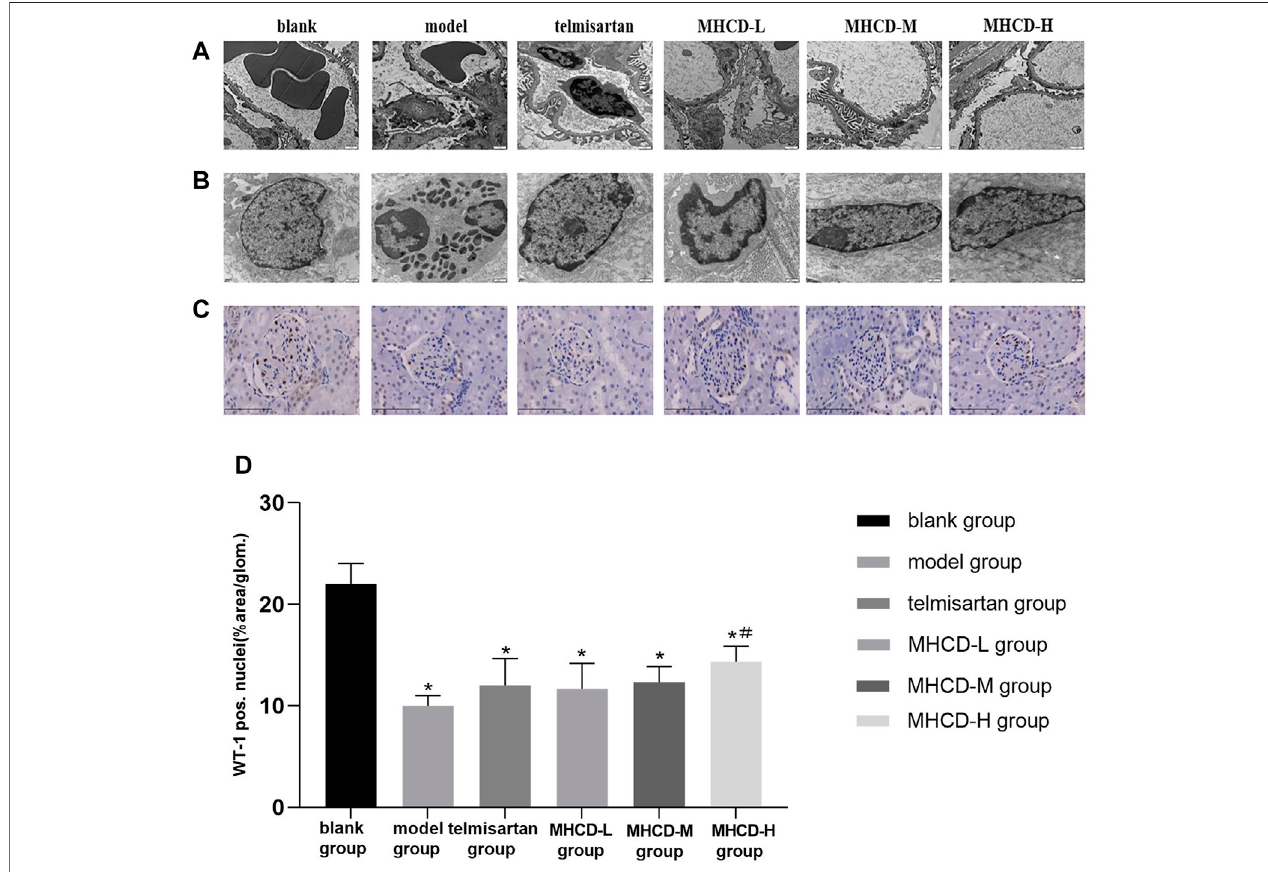
FIGURE 7 | MHCD protects against podocyte injury. (A) The foot process and basement membrane were observed under electron microscopy (magni fi cation × 8,200). (B) Changes in the fi ne structure of the foot process were observed under electron microscopy (magni fi cation × 16,500). (C) WT1 immunohistochemistry of the six groups (magni fi cation × 400). (D) Average percent staining area and WT1-positive podocytes per glomerulum in the IgAN rat model obtained using Image-Pro Plus 6.0 analysis software. Data are expressed as means ± SD ( n (cid:1) 3). * p < 0.05 vs. blank group; ＃ p < 0.05 vs. model group. (E – G) Protein levels of nephrin and podocalyxin in the six groups. For relative quanti fi cation of proteins, β -actin was used as an internal control. The relative expression of proteins was calculated using Image J. Data are expressed as means ± SD ( n (cid:1) 3). *** p < 0.01 vs. blank group; ＃＃ p < 0.01 vs. model group; && p < 0.01 vs. Telmisartan group; ▲▲ p < 0.01 vs. MHCD-L group; ※ p < 0.05 vs. MHCD-M group; * p < 0.05 vs. telmisartan group.